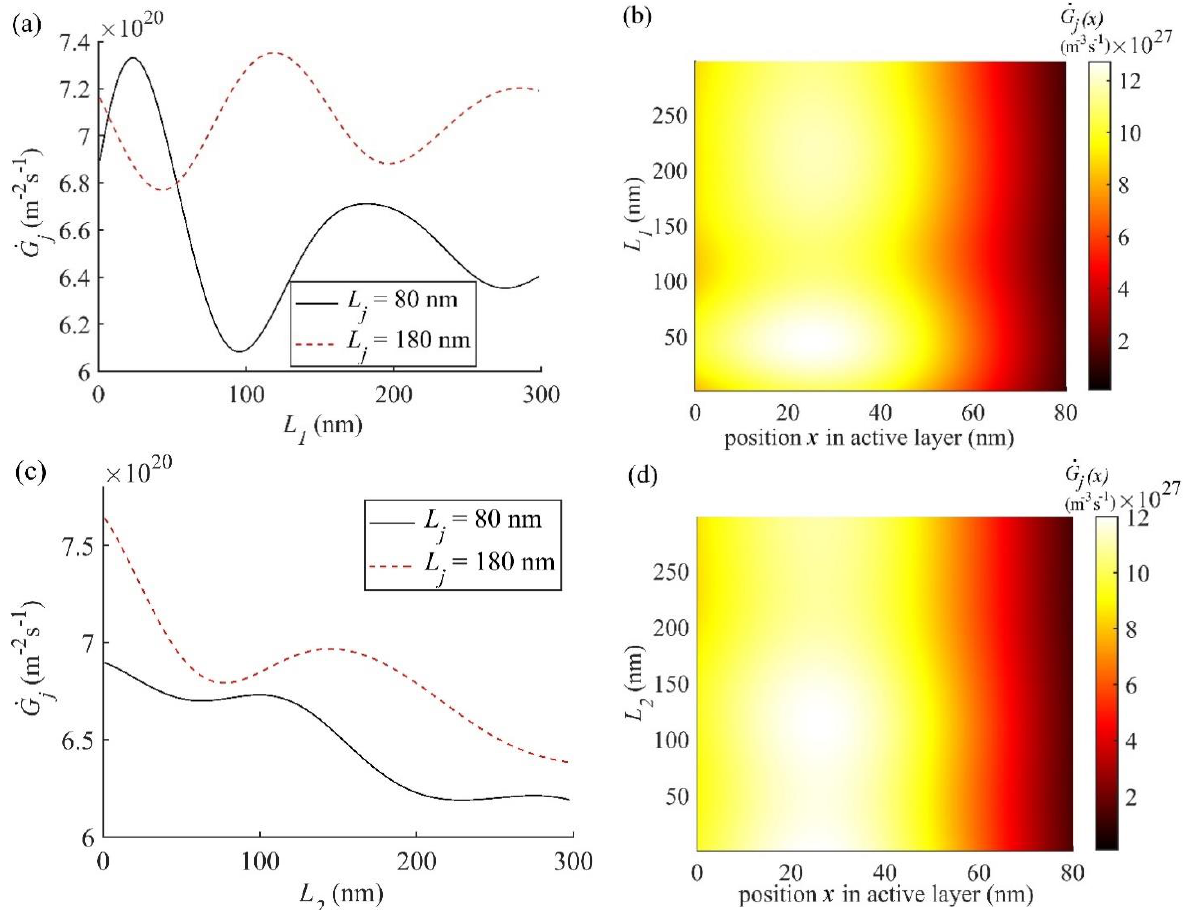
Figure 9. ( a ) 𝐺̇ 𝑗 is plotted as function of the thickness L 1 of layer 1 (ITO) for two active layer thicknesses 𝐿 𝑗 = 80 nm and 180 nm, ( b ) contour plot of 𝐺̇ 𝑗 (𝑥) as function of the thickness L 1 of ITO and position x within the active layer of optimal thickness 𝐿 𝑗 = 80 nm, ( c ) 𝐺̇ 𝑗 is plotted as function of the thickness L 2 of layer 2 (PEDOT:PSS) for two active layer thicknesses 𝐿 𝑗 = 80 nm and 180 nm, and ( d ) contour plot of 𝐺̇ 𝑗 (𝑥) as function of the thickness L 2 of PEDOT:PSS and position x within the active layer of optimal thickness 𝐿 𝑗 = 80 nm.